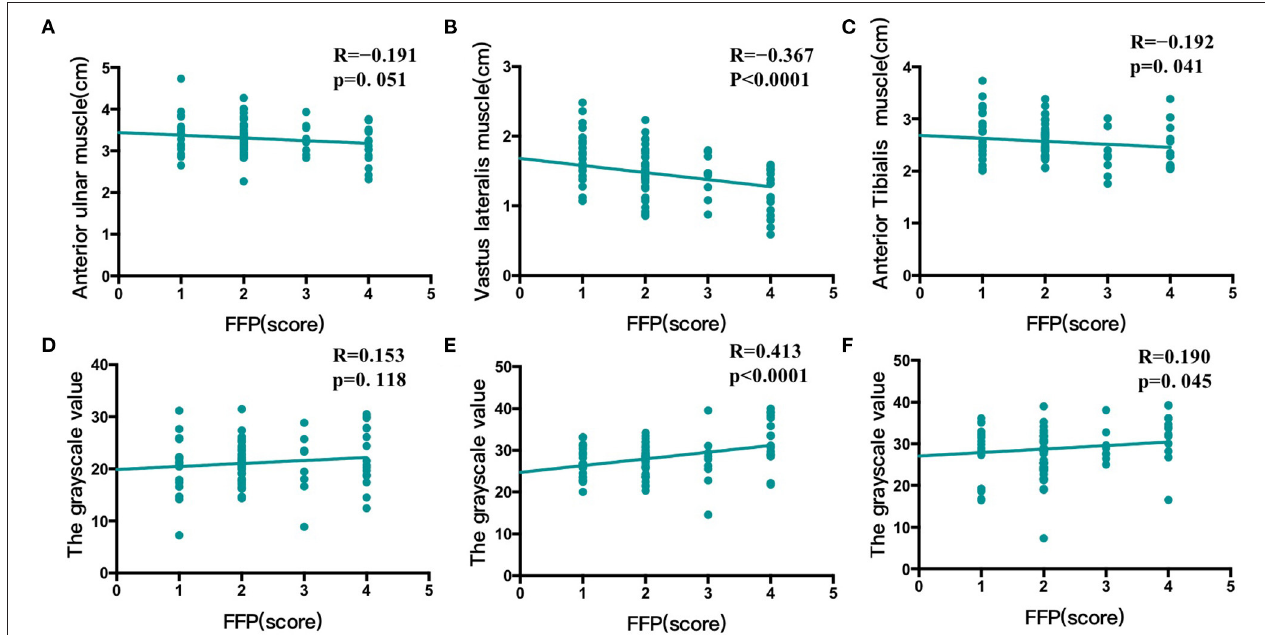
FIGURE 2 | Correlation between FFP and muscle thickness and quality of anterior ulnar muscle, vastus lateralis muscle and anterior tibialis muscle. (A) There was no correlation between fried frailty phenotype (FFP) and the thickness of anterior ulnar muscle (B) FFP was negatively correlated with the thickness of vastus lateralis muscle (C) FFP was negatively correlated with the thickness of anterior tibialis muscle (D) There was no correlation between FFP and the gray value of anterior ulnar muscle (E) FFP was positively correlated with the gray value of vastus lateralis muscle (F) FFP was positively correlated with the gray value of anterior tibialis